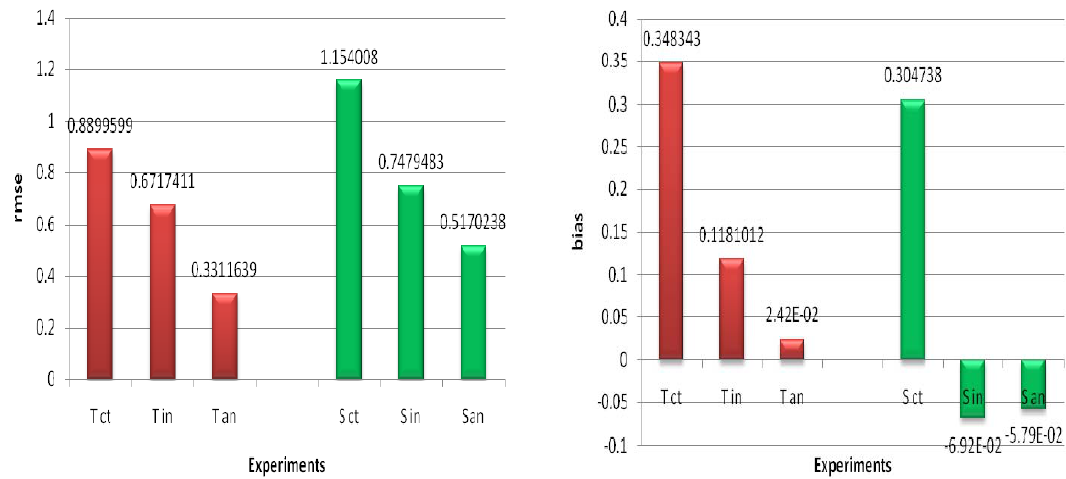
Fig. 8. The gross RMSE (left panel) and bias (right panel) of T/S for control ( T ct / S ct ), 3DVAR data assimilation innovation ( T in / S in ), as well as 3DVAR data assimilation analysis residual ( T an / S an ).